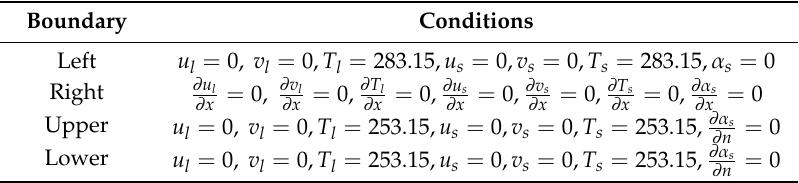
Table 6. The settings of the boundary conditions (Case ex).